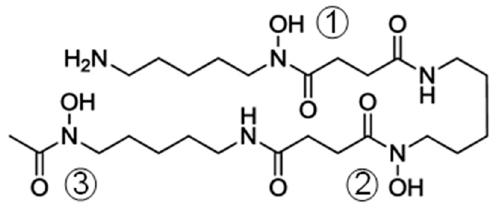
Figure 1. Desferrioxamine (H 3 DFO). Hydroxamate chelating units are highlighted by the numbering.